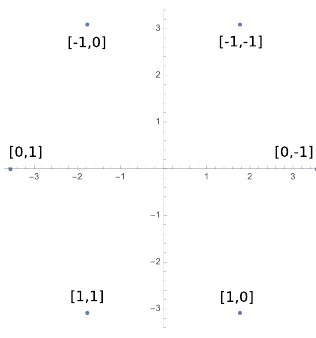
Figure 12 . Central charges of BPS particles in the theory at m = 0 , u = 0 , Λ = 1